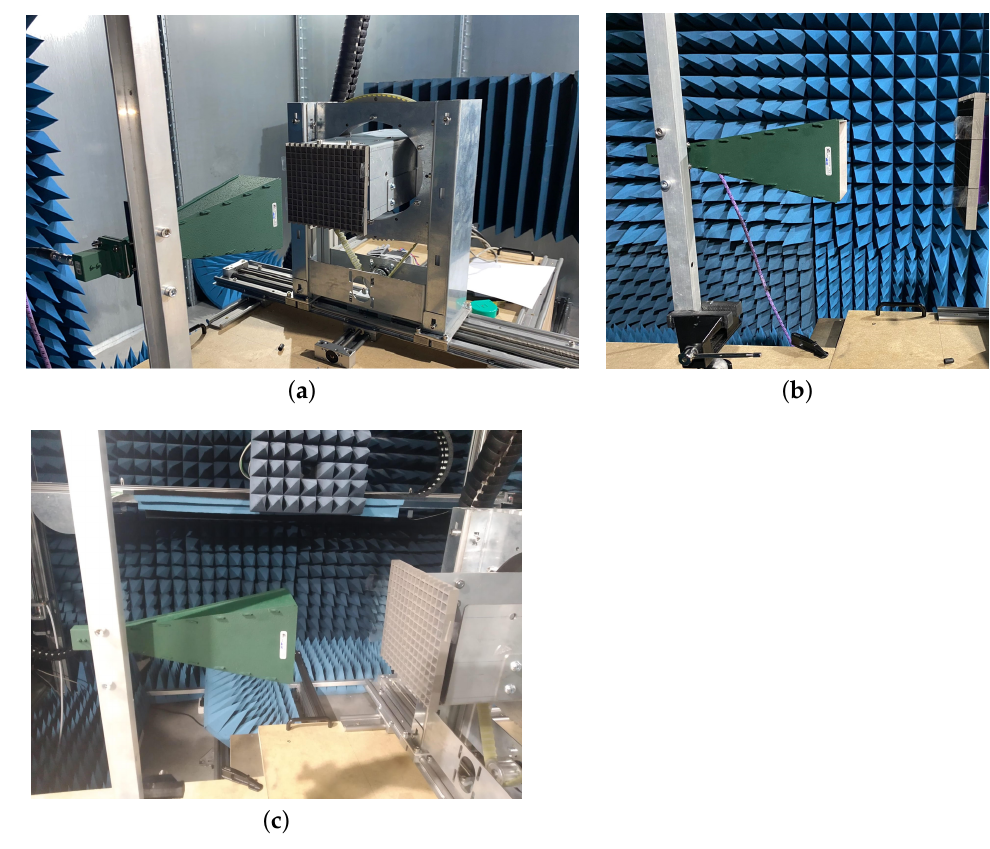
Figure 7. RA Antenna prototype mounted in its final configuration ( a , b ), and ( c ) measuring setup at the antenna measuring facility of the SWAT Group at the University of Granada.